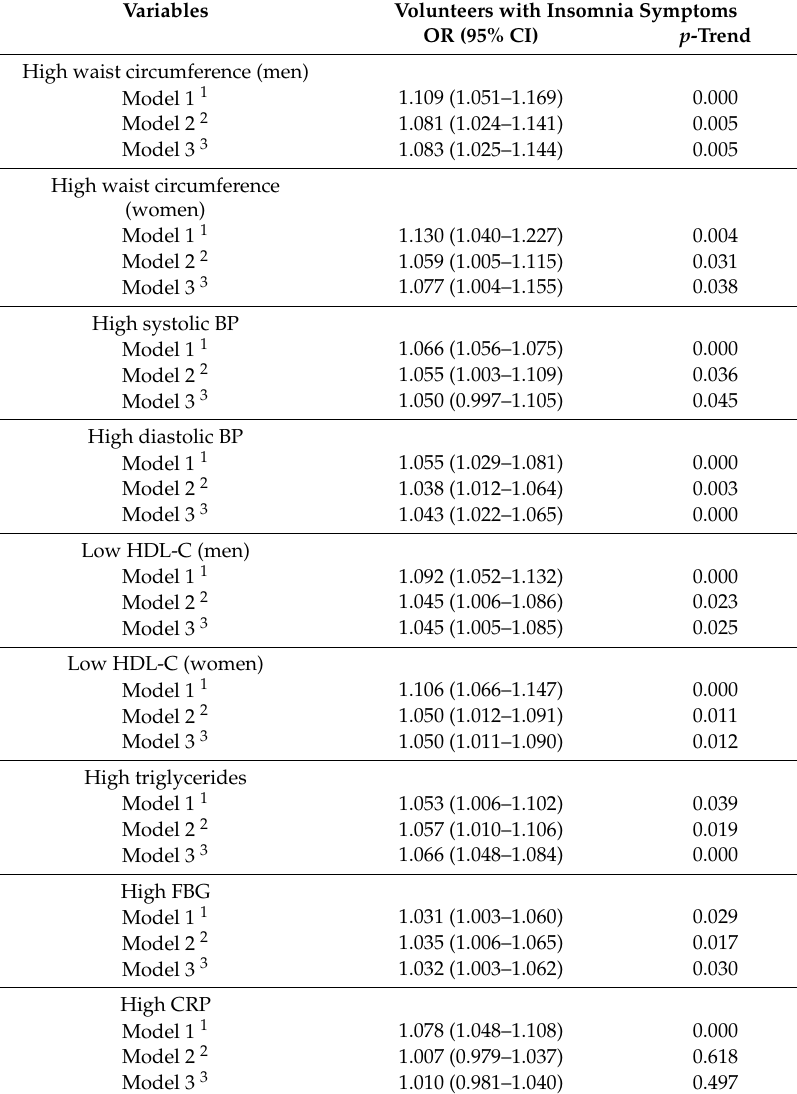
Table 3. Odds ratios (95% CI) of the components of metabolic syndrome and C-reactive protein across volunteers with insomnia symptoms. OR: odds